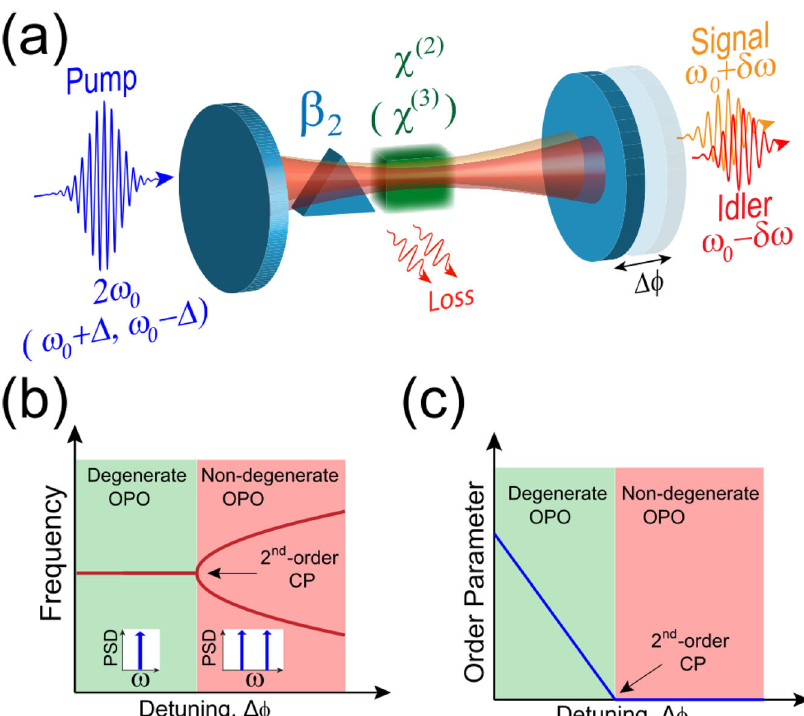
Fig. 1 Spectral phase transition in nonlinear photonic resonators. a OPO with the resonant signal and idler in the cavity with variable detuning ( Δ ϕ ) and second-order group-velocity dispersion ( β 2 ). The nonlinearity can be provided by a quadratic ð χ 2 ð Þ Þ or a Kerr ð χ 3 ð Þ Þ medium. b A second-order phase transition occurs at the critical detuning that marks the transition between the degenerate and the non-degenerate spectrum. c This transition is characterized by a continuous order parameter, but a discontinuous derivative of the order parameter at the critical point